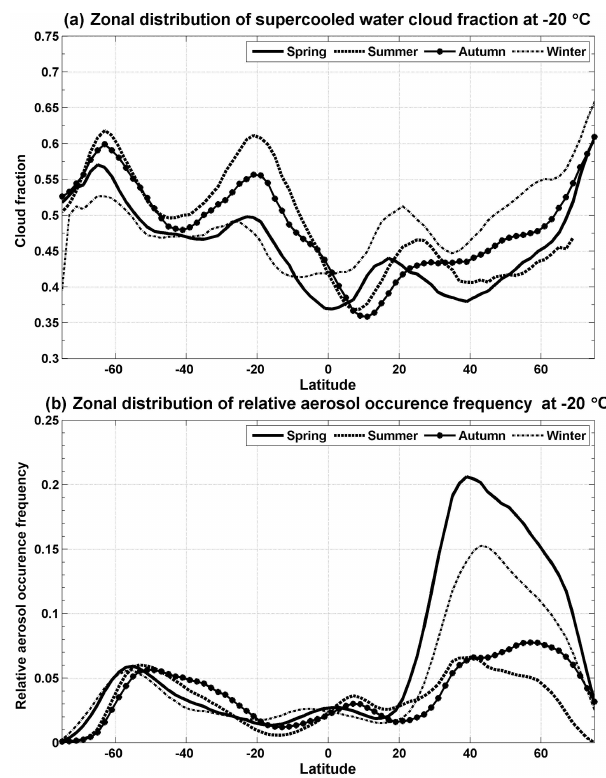
Figure 4. The zonal and seasonal variations of SCFs and RAFs dur- ing nighttime at − 20 ◦ C